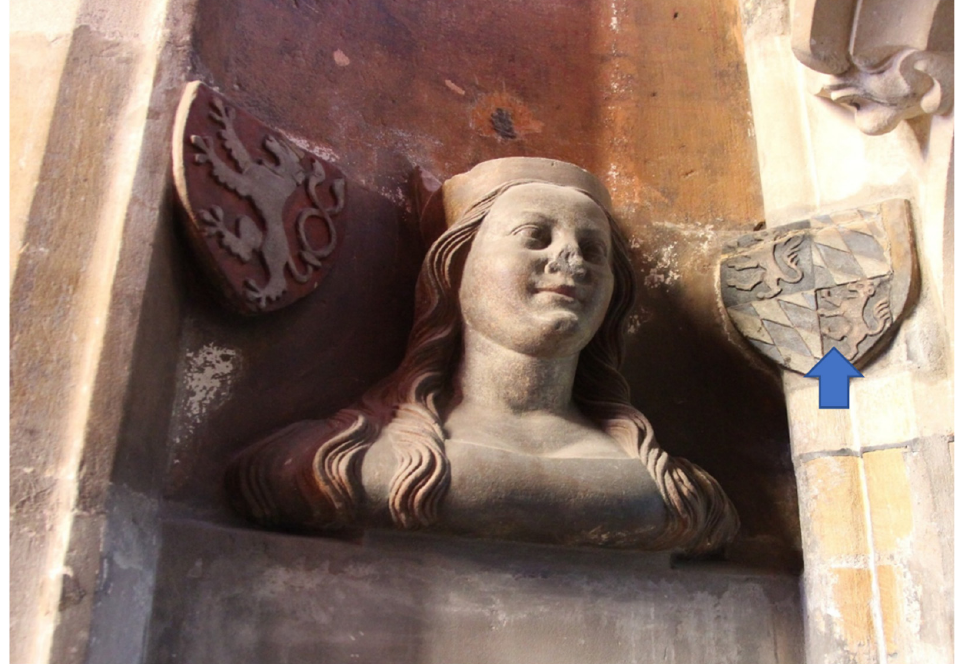
Figure 3. Bust—Anna Palatinate (Anna Pfalz), arrow indicates measured position.